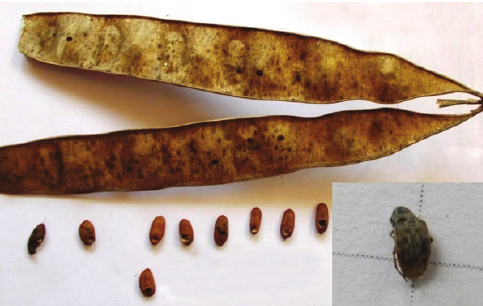
FIGURE 1. Bruchidius terrenus in Albizia jullibrisin , damaged pods, seeds and adult insect